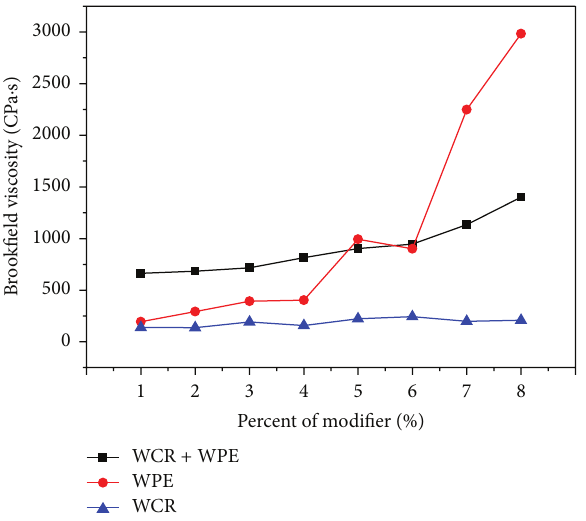
Figure 5: The viscosity of modified asphalt at 165 ∘ C.